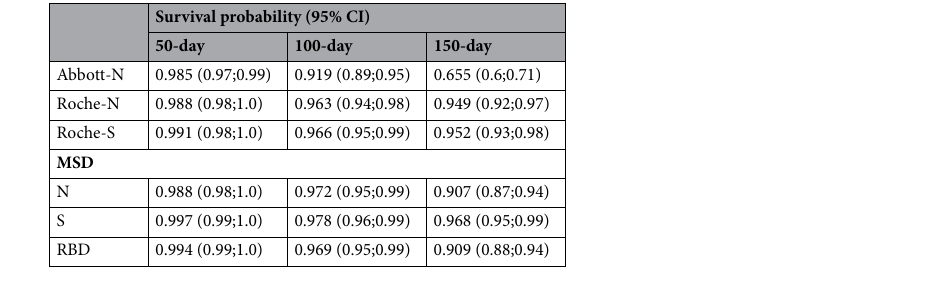
Table 2. Sensitivity of compared assays at 50, 100 and 150 days from symptom onset.